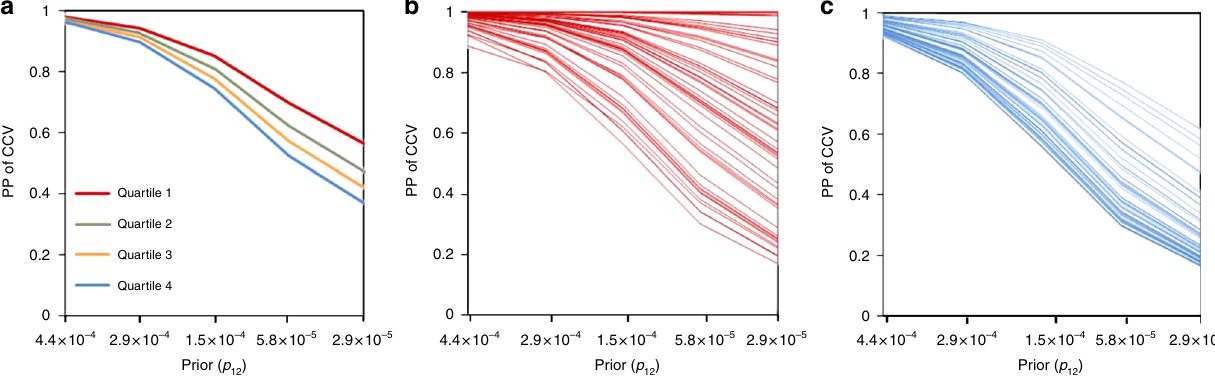
Fig. 4 The posterior probability (PP) of sharing a common causal variant (CCV) depends on the extent of LD in the region. a Average PPs of CCV at different priors ( p 12 ) strati fi ed by quartiles of LD score of the region. b PP of CCV at different prior ( p 12 ) for the lead eSNPs with the lowest LD score (50 SNPs). c PP of CCV at different prior ( p 12 ) for the 50 lead eSNPs with the highest LD score (50